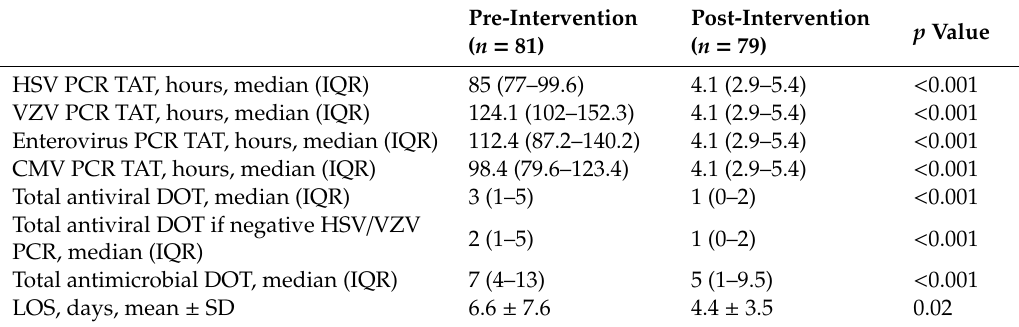
Figure 2. Detected Pathogens. Abbreviations: HSV: Herpes simplex virus, VZV: Varicella-zoster virus, CMV: Cytomegalovirus, EBV: Epstein-Barr virus. Table 2. Primary and Secondary